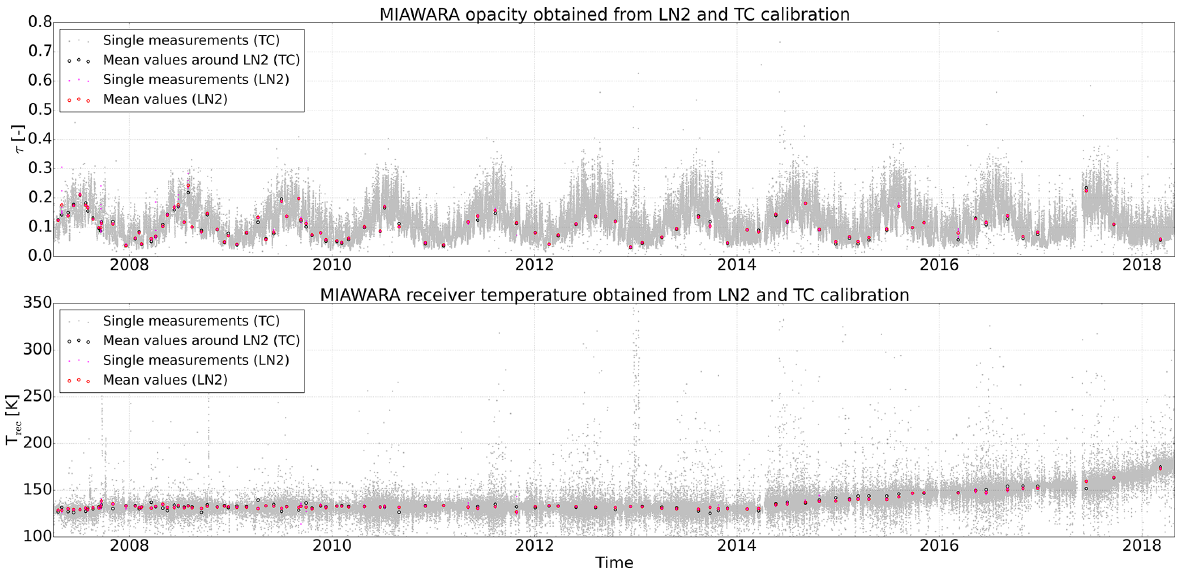
Figure 1. Development of the tropospheric opacities and the MIAWARA receiver temperatures as obtained from tipping curve (TC) (opera- tional, grey dots) and regular liquid nitrogen (LN2) verification calibrations (mean values shown by red markers). The mean values around LN2 can be compared to the mean values around TC that are shown by the black markers. The time period between April 2007 and May 2018 is